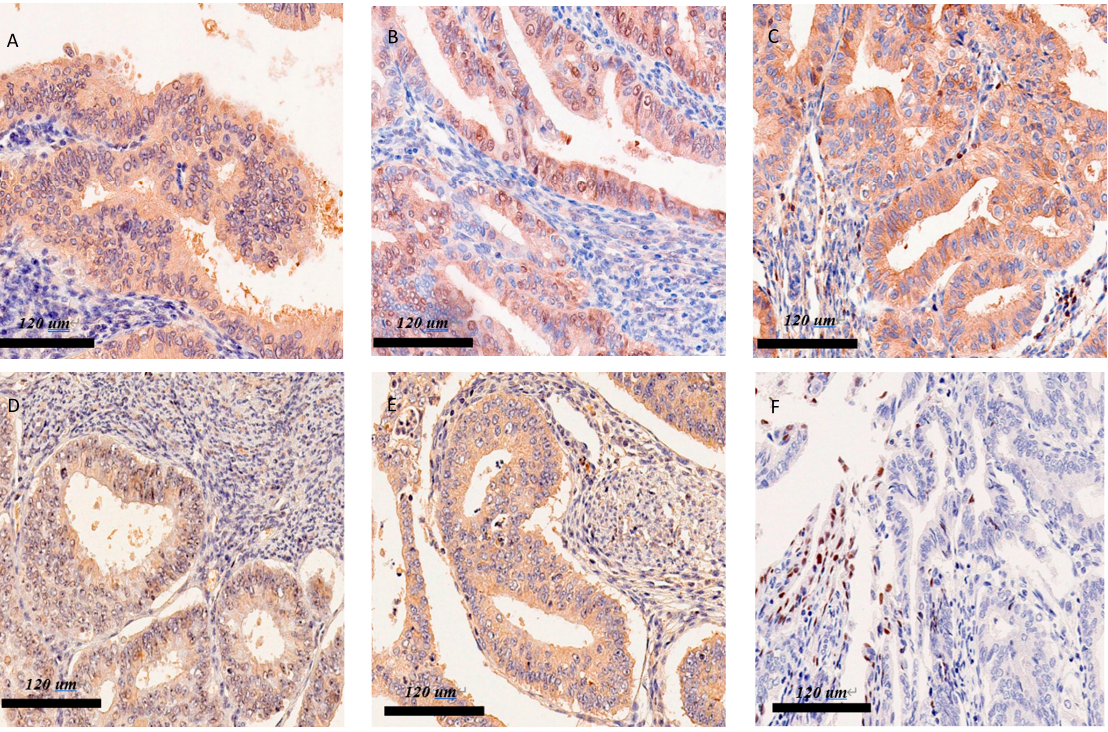
Figure 1. ( A ) Immunohistochemical staining: Cytoplasm of cancer cells shows diffuse expression of YAP (×400). ( B ) Cytoplasm of cancer cells shows diffuse expression of p -YAP (×400). ( C ) Diffuse expression of MST1/2 in the cytoplasm (×400). ( D ) Diffuse positive signal of KIBRA in the cytoplasm of cancer cells (×400). ( E ) Diffuse positive signal of Merlin in the cytoplasm of cancer cells (×400). ( F ) Diffuse positive signal of LATS1/2 in the cytoplasm of cancer cells (×400). Table 2. Association between expression levels of YAP and p -YAP and other core proteins of Hippo pathway. YAP p